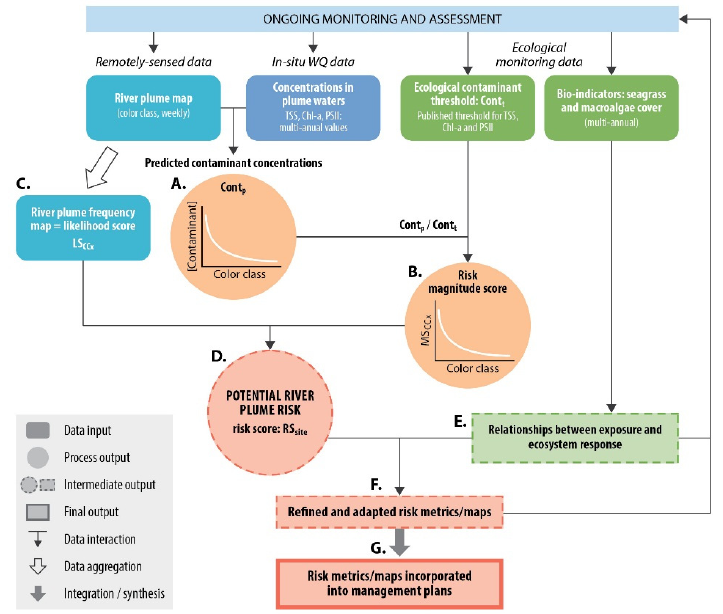
Figure 3. Conceptual model of the Satellite Risk Framework presented in this study, including data sources, main outputs and the different steps necessary to implement the framework. ( A ) comparison of river plume water type maps and in situ water quality measurements; ( B ) calculation of a magnitude score for each plume water type; ( C ) calculation of a likelihood score (frequency of exposure) at the seagrass and coral sites locations; ( D ) calculation of a river plume risk score (magnitude × likelihood) at the seagrass and coral sites locations; ( E ) correlation between bio-indicator responses and their risk score; ( F ) derivation of multiannual risk score thresholds and generation of intermediate river plume risk maps specifically for seagrass meadows and coral reefs of the GBR. The risk score thresholds and maps will be refined and validated through ongoing monitoring and assessment; ( G ) Incorporation of these products into applied management actions as useful tools to monitor and mitigate water quality impacts on ecosystem health in the